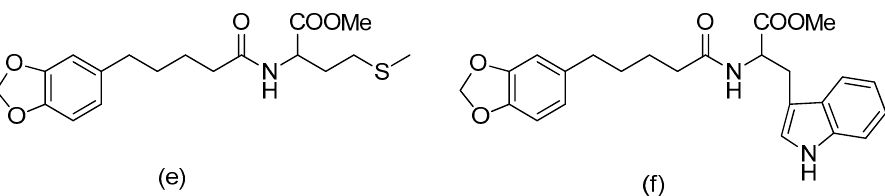
Figure 2. ( a ) Piperoyl-L-valine methyl ester; ( b ) tetrahydropiperoyl-L-phenylalanine methyl ester; ( c ) tetrahydropiperoyl-L-tyrosine methyl ester; ( d ) tetrahydropiperoyl-L-valine methyl ester; ( e ) tetrahydropiperoyl-L-methionine methyl ester; ( f ) tetrahydropiperoyl-L-tryptophan methyl ester.